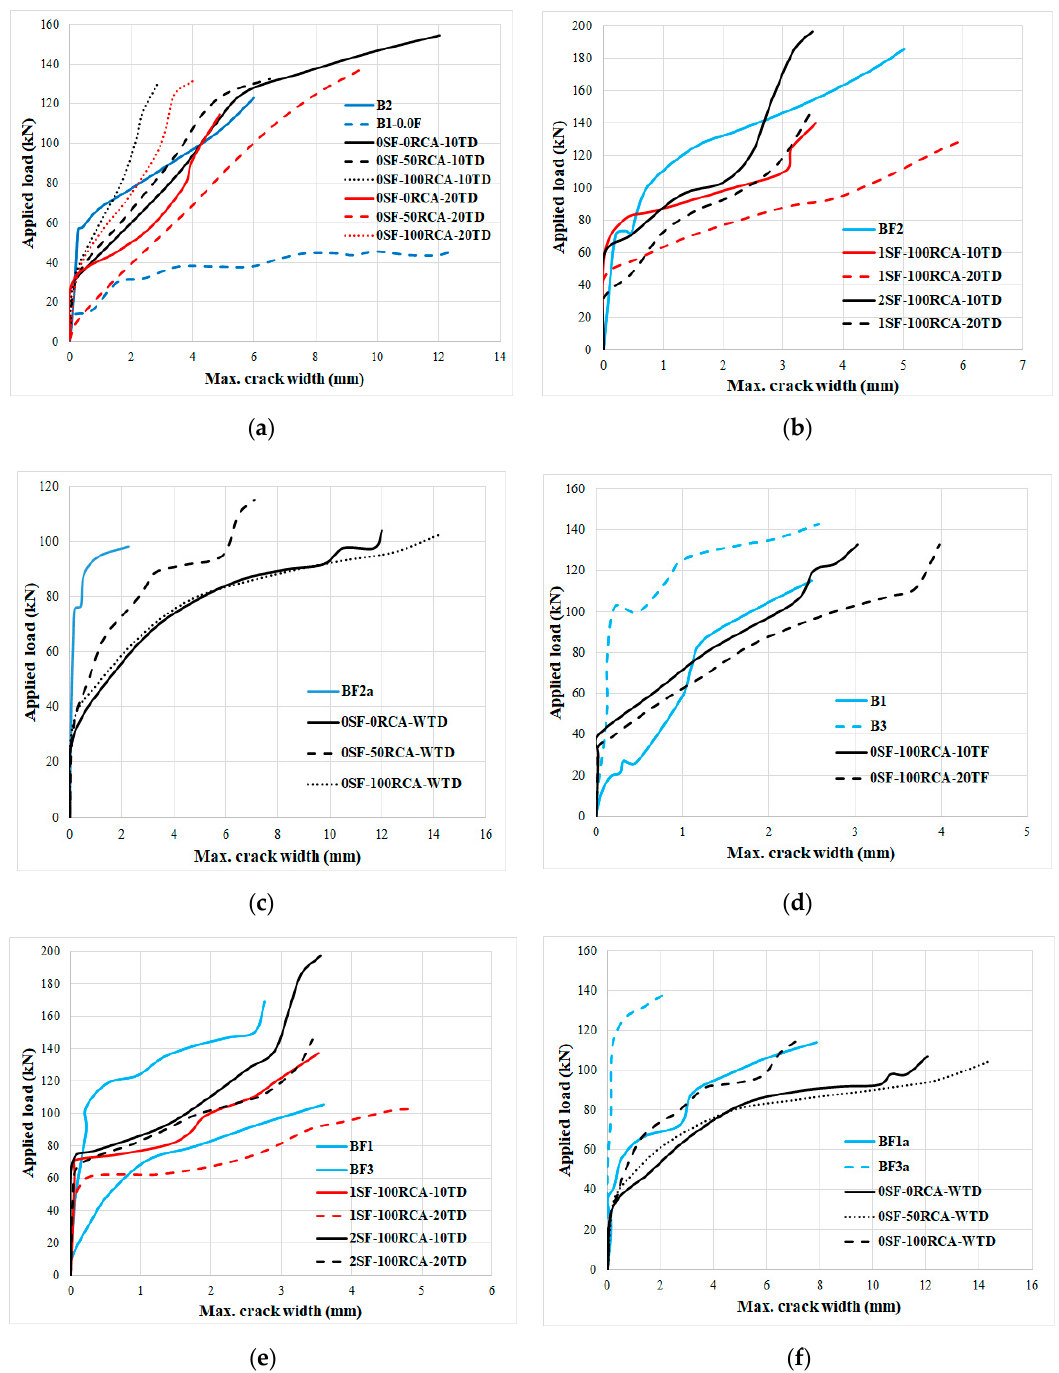
Figure 21. Applied load–crack width performance of specimens with various SF and RA contents ( a ) specimens without SF with different RCA contents, ( b ) specimens with different SF contents and 100% RCA, ( c ) specimens without SF and stirrup, ( d ) specimens without SF and with 100% RCA, ( e ) specimens with different SF contents, 100 RCA and different stirrup spacing and ( f ) specimens without fibres and stirrup with different RCA contents Table 6. Characteristics of the various specimens.